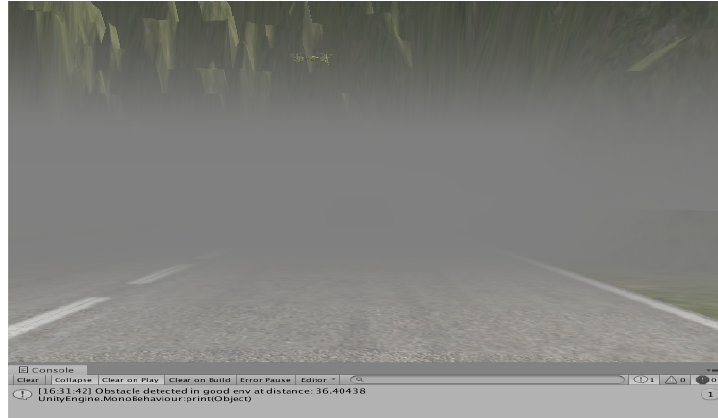
Figure 16. The second obstacle with a foggy area.